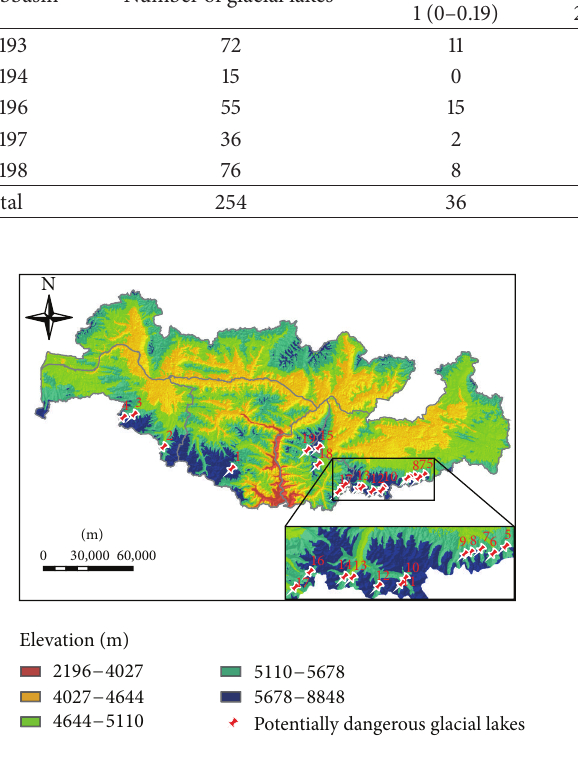
Figure 4: Distribution of potentially dangerous glacial lakes in the Pumqu river basin (the ID is according to Table 4).